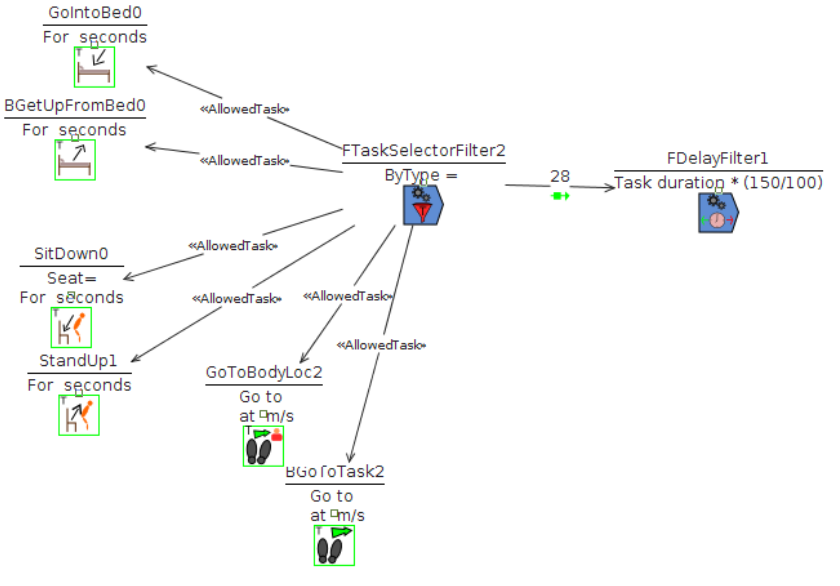
Figure 7. Filter applied to the movement problems simulation.